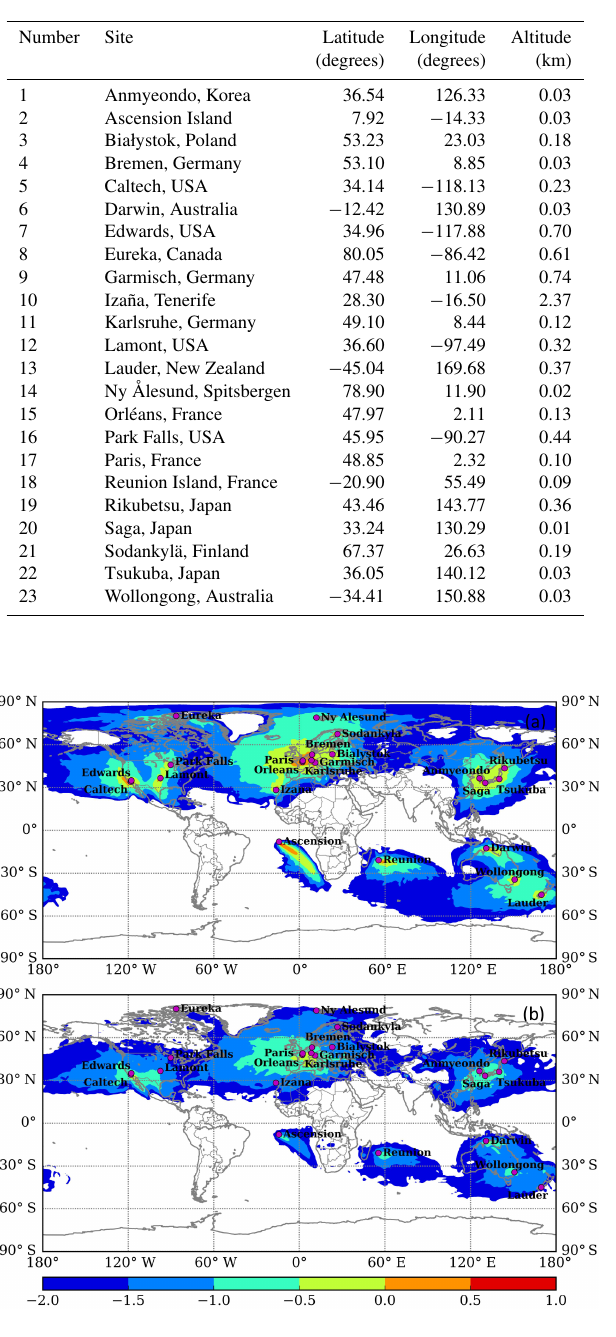
Figure 1. Global distribution of the sensitivity of CO 2 concentra- tions (ppm(µmol(m 2 s) − 1 ) − 1 ) with respect to the concentrations in adjacent cells, calculated using the FLEXPART model with a resolution of 1.0 ◦ for the 23 TCCON operational sites: (a) tracer simulation initialised at the level of 1000m, (b) tracer simulation initialised at the level of 3000m that corresponds to 700hPa based on the International Standard Atmosphere for dry air.